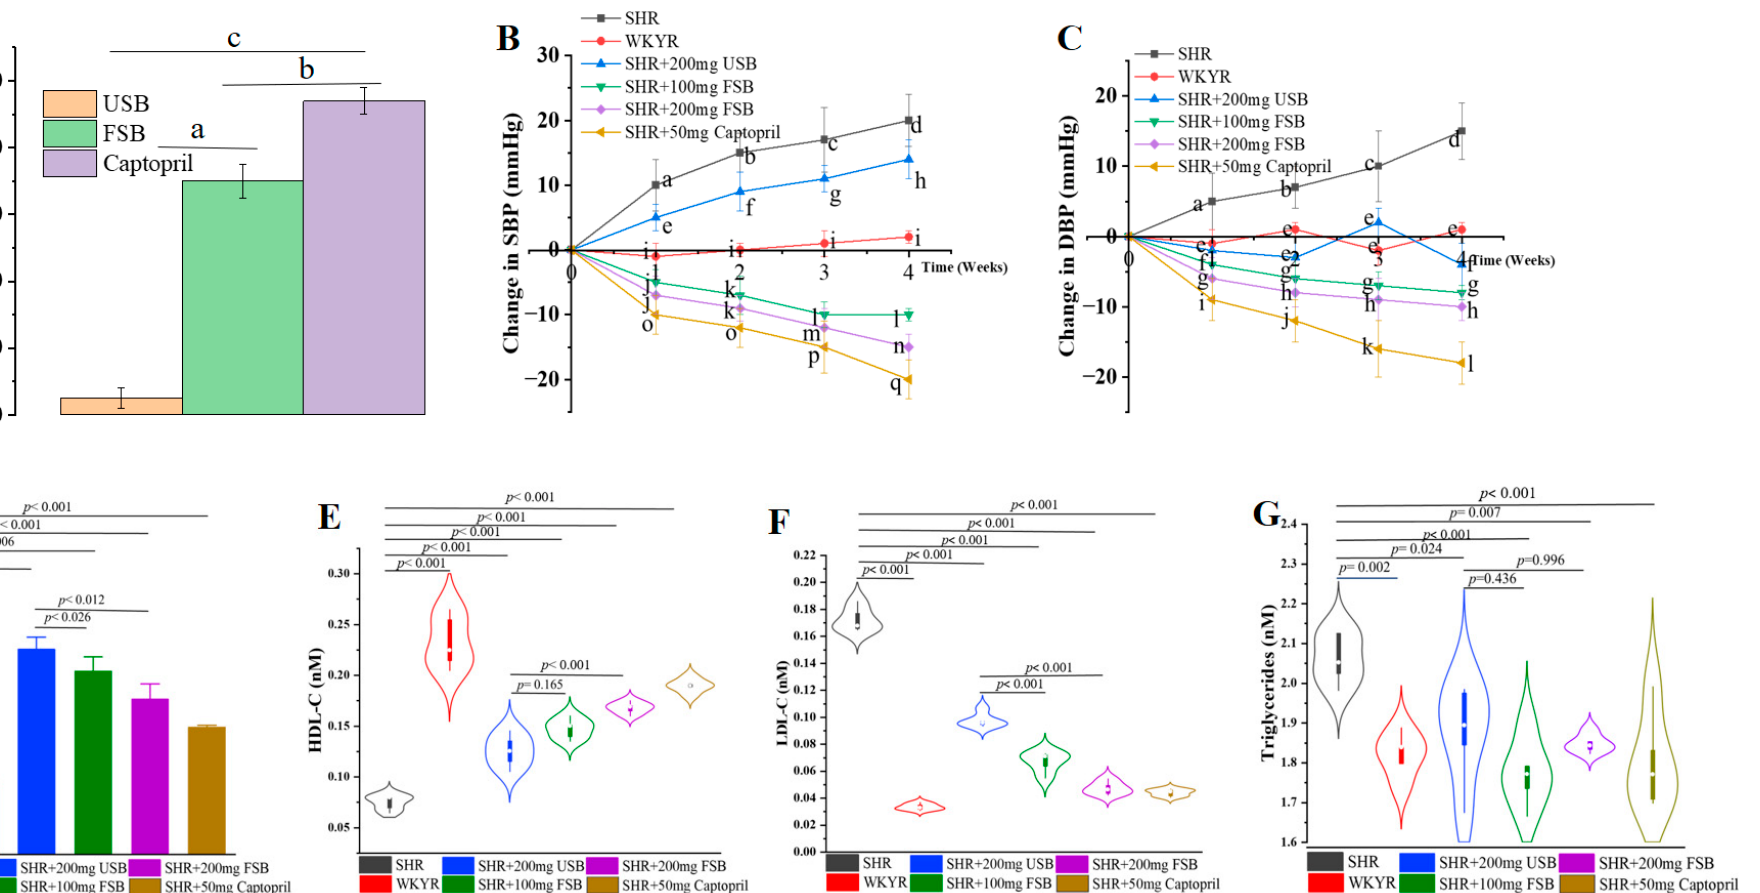
Figure 1. Effects of FSB and USB on ACE, blood pressure, serum ACE activity and serum atherogenic lipids in SHR. ( A ). ACE-1 inhibitory ability of FSB and USB compared to Captopril. All bars represent means of three readings (n = 3) ± S.D. Bars with different alphabets were significantly different ( p < 0.05) according to paired t -tests. ( B , C ). Effects of FSB and USB consumption on systolic and diastolic blood pressure of SHR compared to WKYR and untreated SHR. ( D , E , F,G ). Effects of FSB and USB on serum ACE, HDL-C, LDL-C, and triglycerides of SHR compared to WKYR and untreated SHR, respectively.